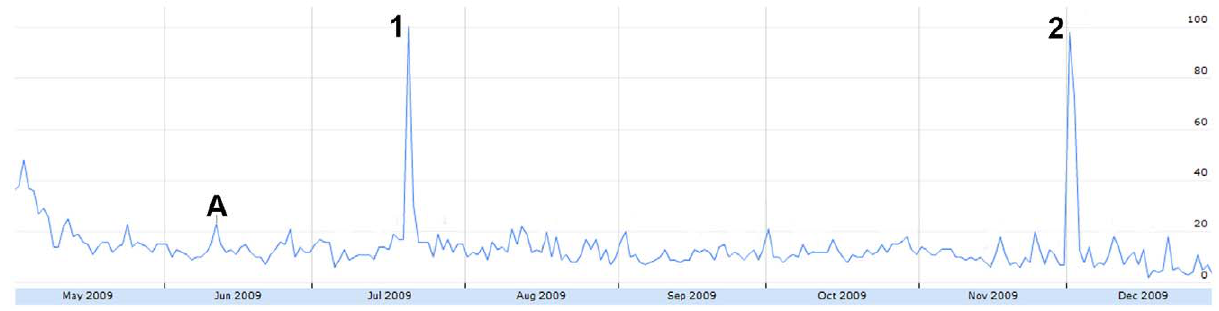
Figure 12. The relative proportion of tweets expressing downplayed risk from May 1 to December 31, 2009. Figure was scaled to the highest peak on July 20 where 6.96% of all tweets expressed downplayed risk. The peak was assigned a score of 100. A=June 11: WHO pandemic level 6 announcement. 1=July 20: Viral dissemination of the ‘‘face mask (H1N1) versus condom (AIDS) comparison.’’ 2=Dec 1: Viral dissemination of the ‘‘face mask (H1N1) versus condom (AIDS) comparison.’’